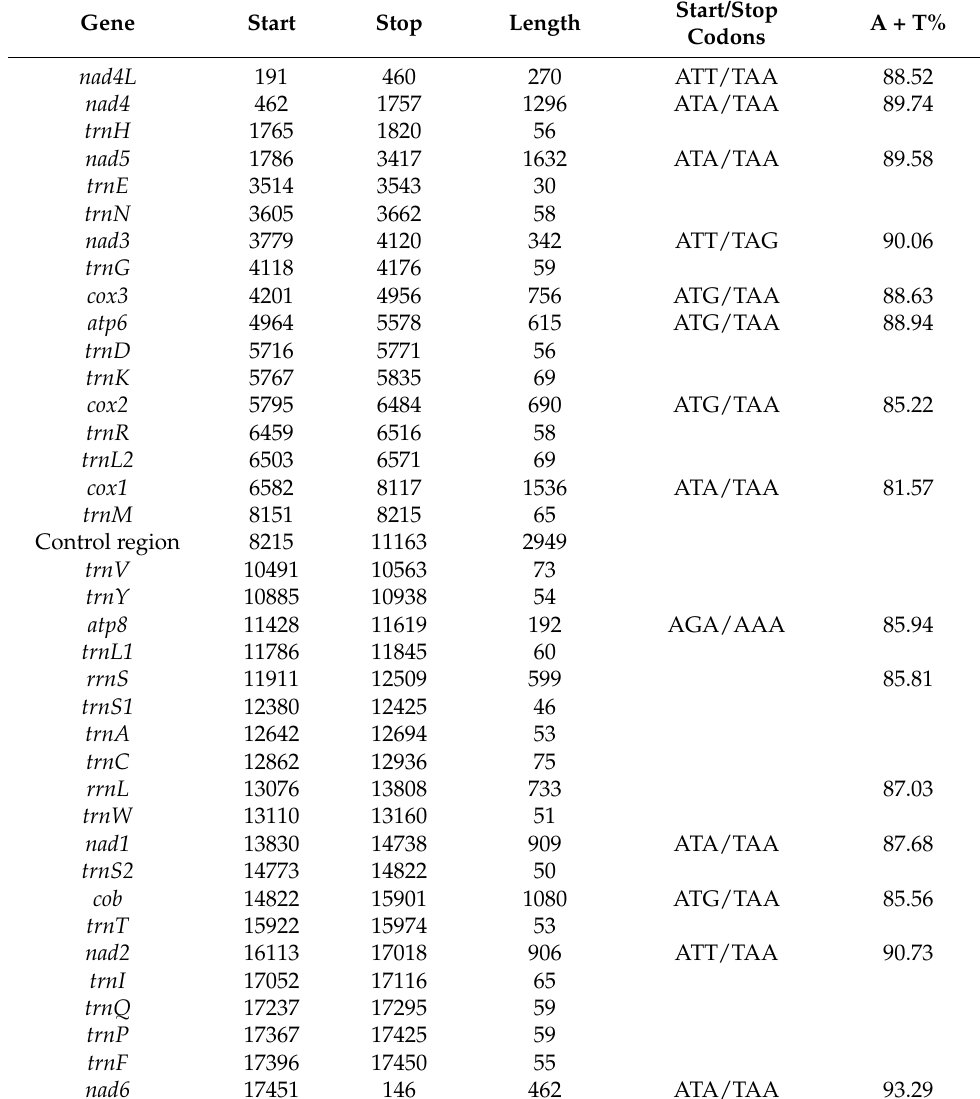
Table 3. Gene composition, Gene’s corresponding start/stop codons and AT